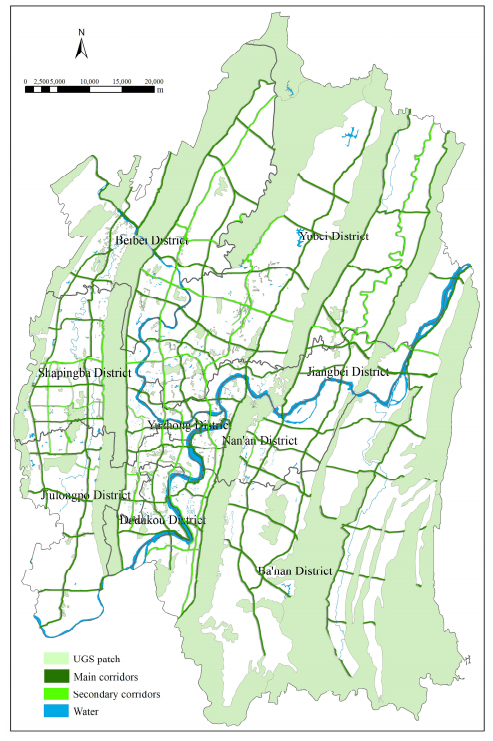
Figure 7. UGS planning optimization of Chongqing urban areas.